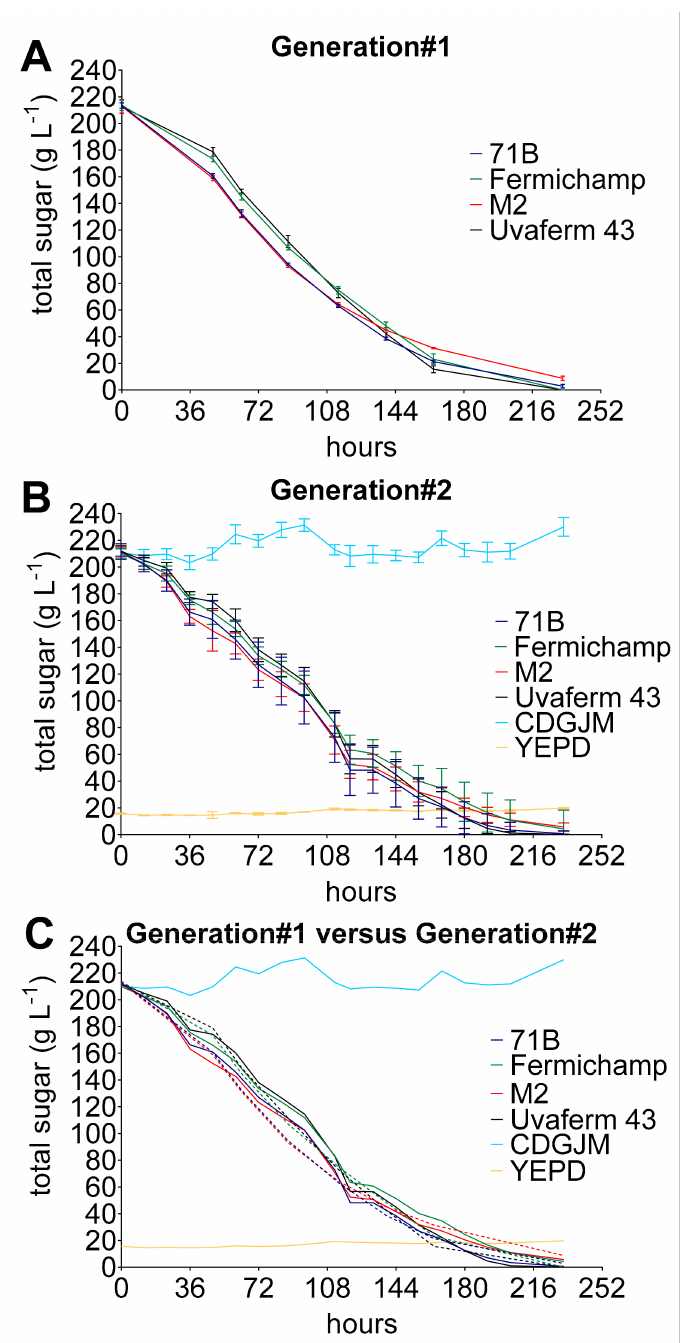
Figure 6. Comparison of sugar consumption by four commercial yeasts fermented as 100 mL cultures (Generation#1) versus 30 mL cultures (Generation#2) in CDGJM. Four commercial wine yeast were inoculated from YEPD starter cultures at 1% in CDGJM (115 g L − 1 glucose, 115 g L − 1 fructose; 350 mg L − 1 FAN). Graphs depict residual sugar (g L − 1 ) over time (hours). ( A ) 3 replicates per strain (Generation#1). ( B ) 19 replicates per strain (Generation#2). ( C ) Overlay of the sugar curves produced from the two ‘Teebot’ platforms. Sterility controls (9 replicates) were included in the Generation#2 experiment (YEPD, 20 g L − 1 sugar and CDGJM, 230 g L − 1